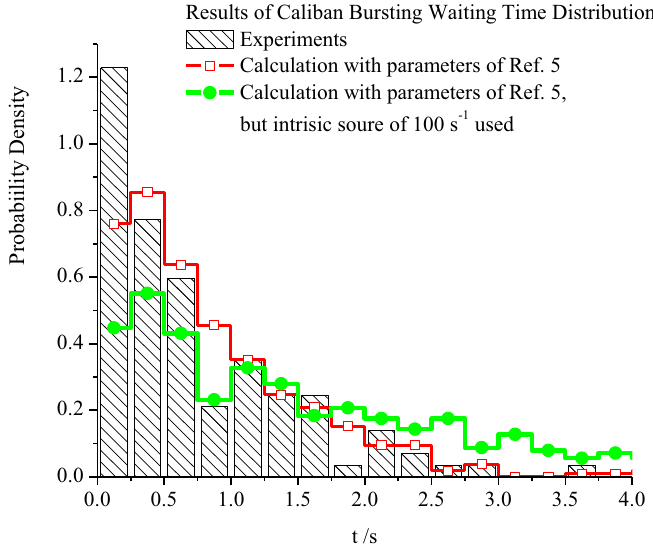
Figure 1. Comparisons between the experiments and